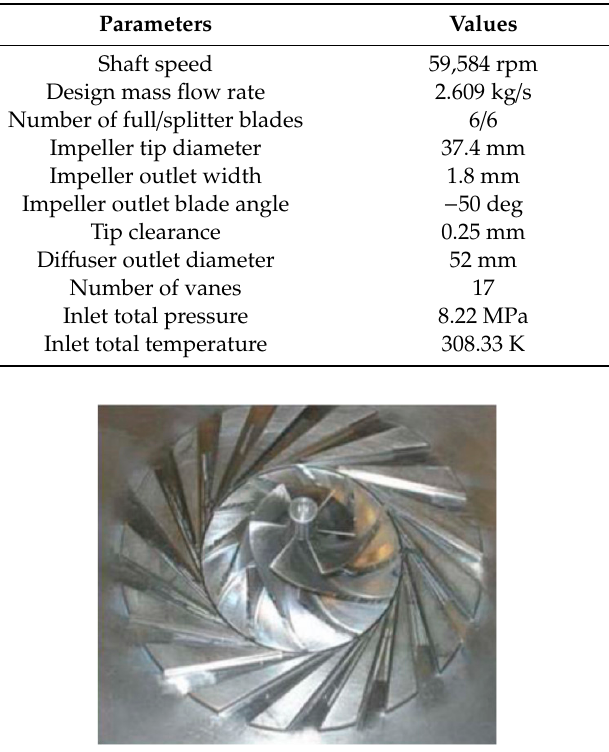
Table 1. Design parameters of the Sandia Supercritical Carbon Dioxide (SCO 2 ) compressor.